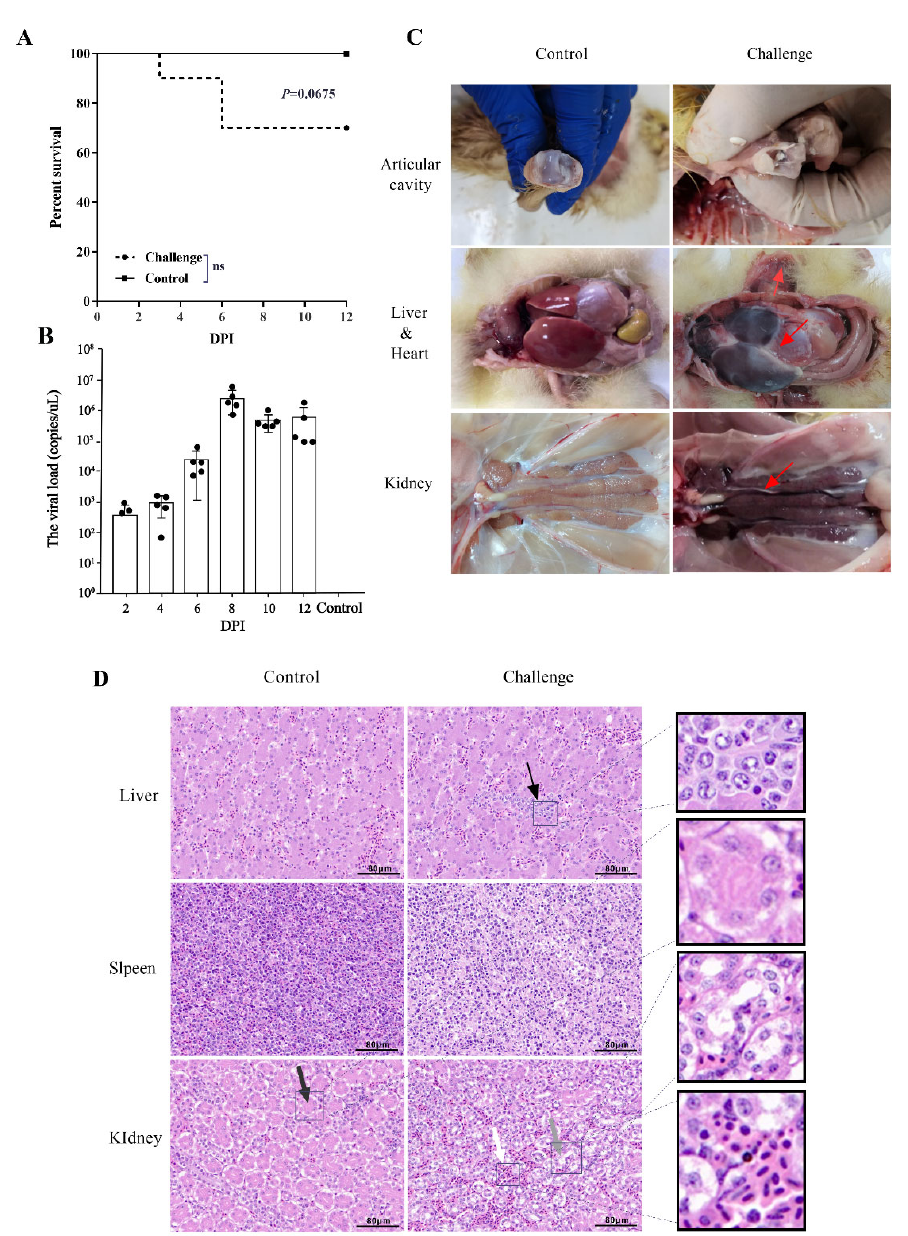
Figure 1. Pathogenicity analysis of GAstV-AHQJ18 strain. ( A ) The survival rates were monitored daily. Survival data were analyzed by log-rank (Mantel–Cox) test. p values: no significant difference (ns) p > 0.05. ( B ) Viral load in cloacal swabs were detected at 2, 4, 6, 8, 10, and 12 dpi. ( C ) Postmortem lesions of goslings infected GAstV-AHQJ18 strain. There were hepatonephromegaly and urate deposits in the articular cavity, peritoneum, crureus, and kidney. Red arrow: urate deposits. ( D ) Histopathological changes in liver, spleen and kidney in goslings. The histopathological changes in the control group were normal. Liver and kidney damage were observed in the infected group. Thin black arrow: necrosis and inflammatory infiltration in liver. Thick black arrow: the normal brush border of the proximal tubule in the control group. Gray arrow: the villi structure disappeared in the infected group. White arrow: lymphocyte infiltration. Scale bar = 80 μ m.